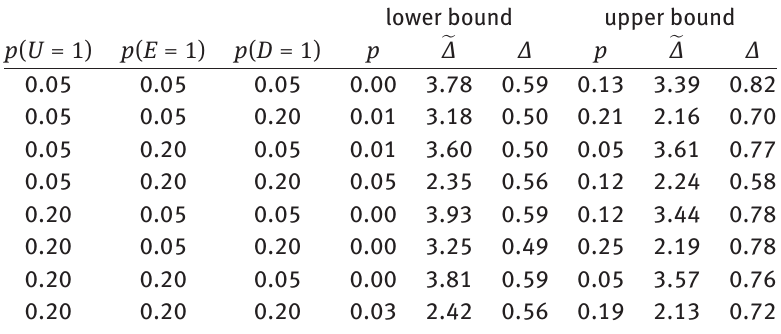
Table 2: Simulation results with σ = 3 . p is the proportion of times that the assumption-free bound was sharper than DV’s (cid:2) Δ are the mean absolute distance between the log of the bound and the log of the true causal risk ratio, for DV’s bound; Δ and bounds and the assumption-free bounds,